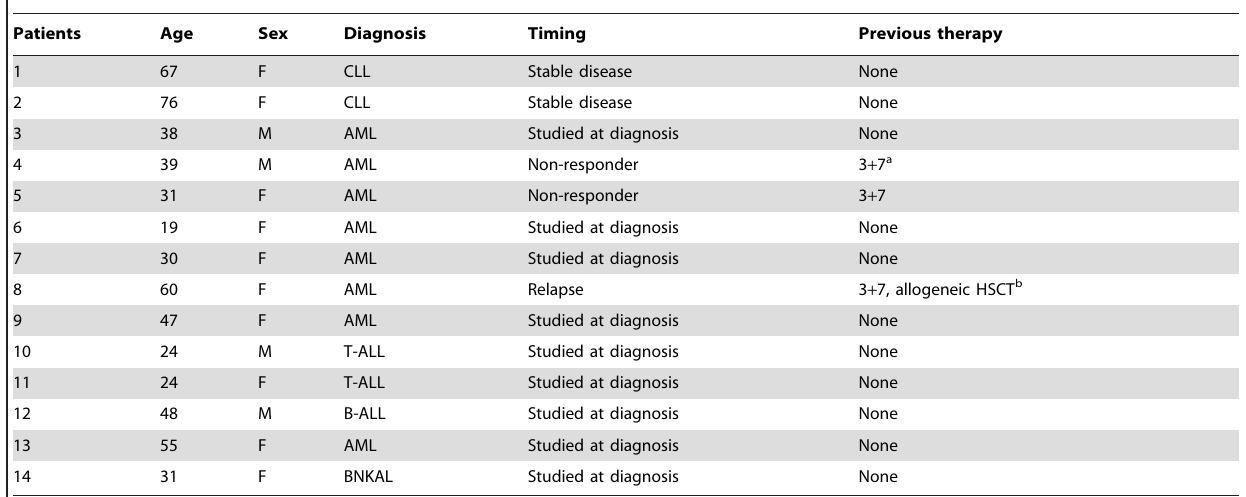
Table 1. Clinical features of